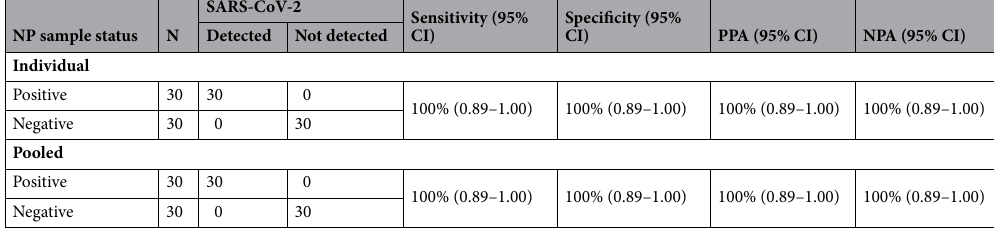
Table 4. Clinical NP sample pooling for SARS-CoV-2 detection with EM Kit. Individual positive and negative samples were blinded, extracted using the Magmax™ Viral/Pathogen Nucleic Acid isolation kit and tested with both the EM Kit and the QuantiVirus™ Real-time PCR coronavirus (SARS-CoV-2) detection kit (individual). Each blinded sample was then pooled with 4 negative NP samples and tested with the EM Kit and compared to the individual QuantiVirus™ Real-time PCR coronavirus (SARS-CoV-2) detection kit (pooled).